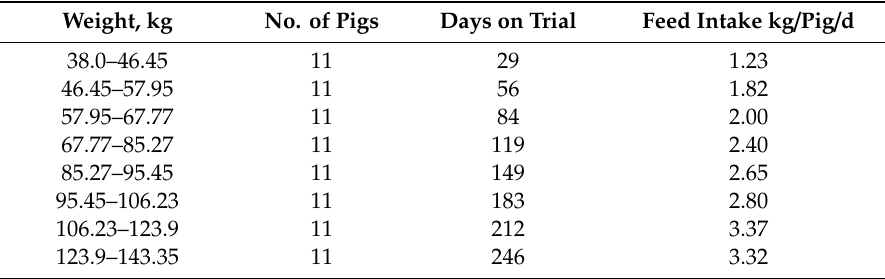
Table A5. Data on Cinta Senese breed used for modelling (Project TREASURE) 1 .